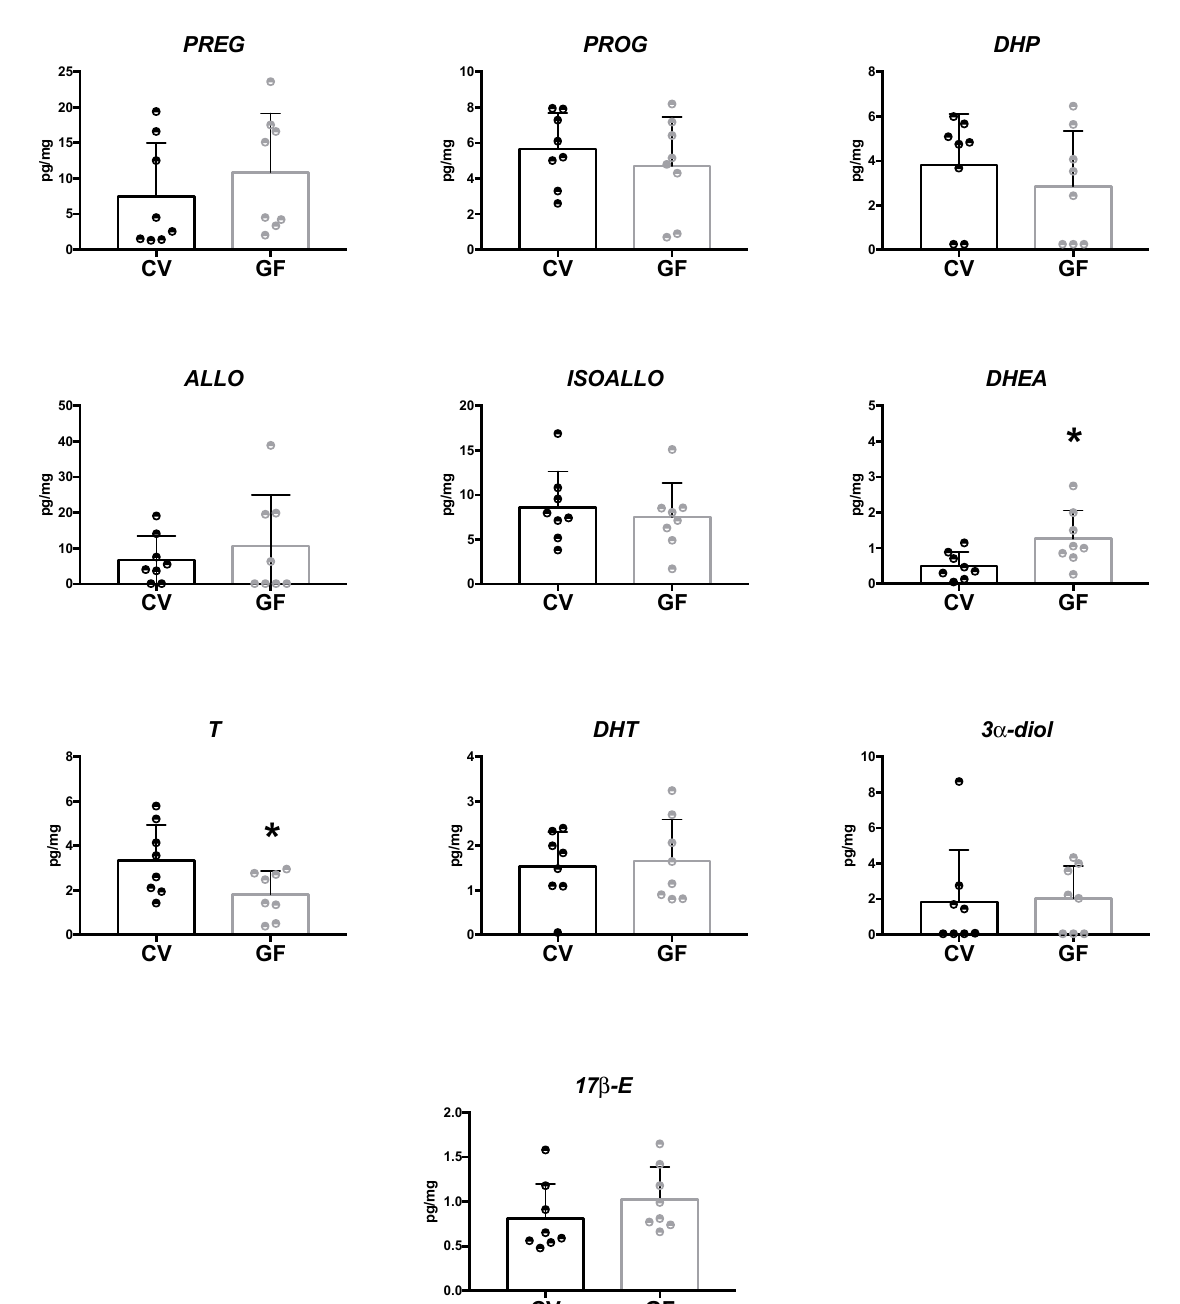
Figure 5. Levels of neuroactive steroids in the hypothalamus of germ-free (GF) and conventional (CV) male mice. Data are expressed as pg/mg ± SD, n = 8 for each group. Unpaired student’s t -test analysis: * p < 0.05 vs. CV mice.